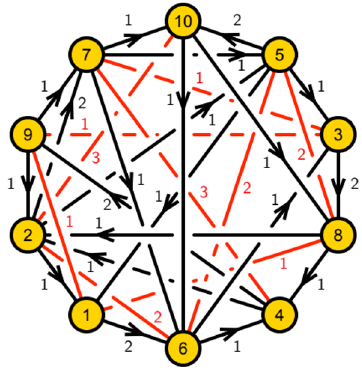
Figure 38 . Quiver for Model